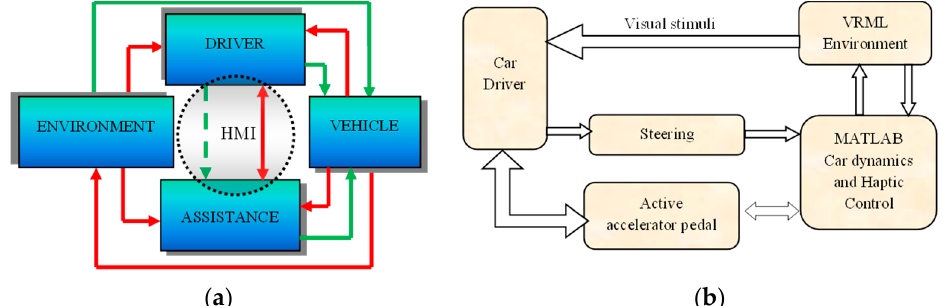
Figure 6. Flow of control signal for human–machine interaction; ( a ) schematic configuration, ( b ) control sequence.